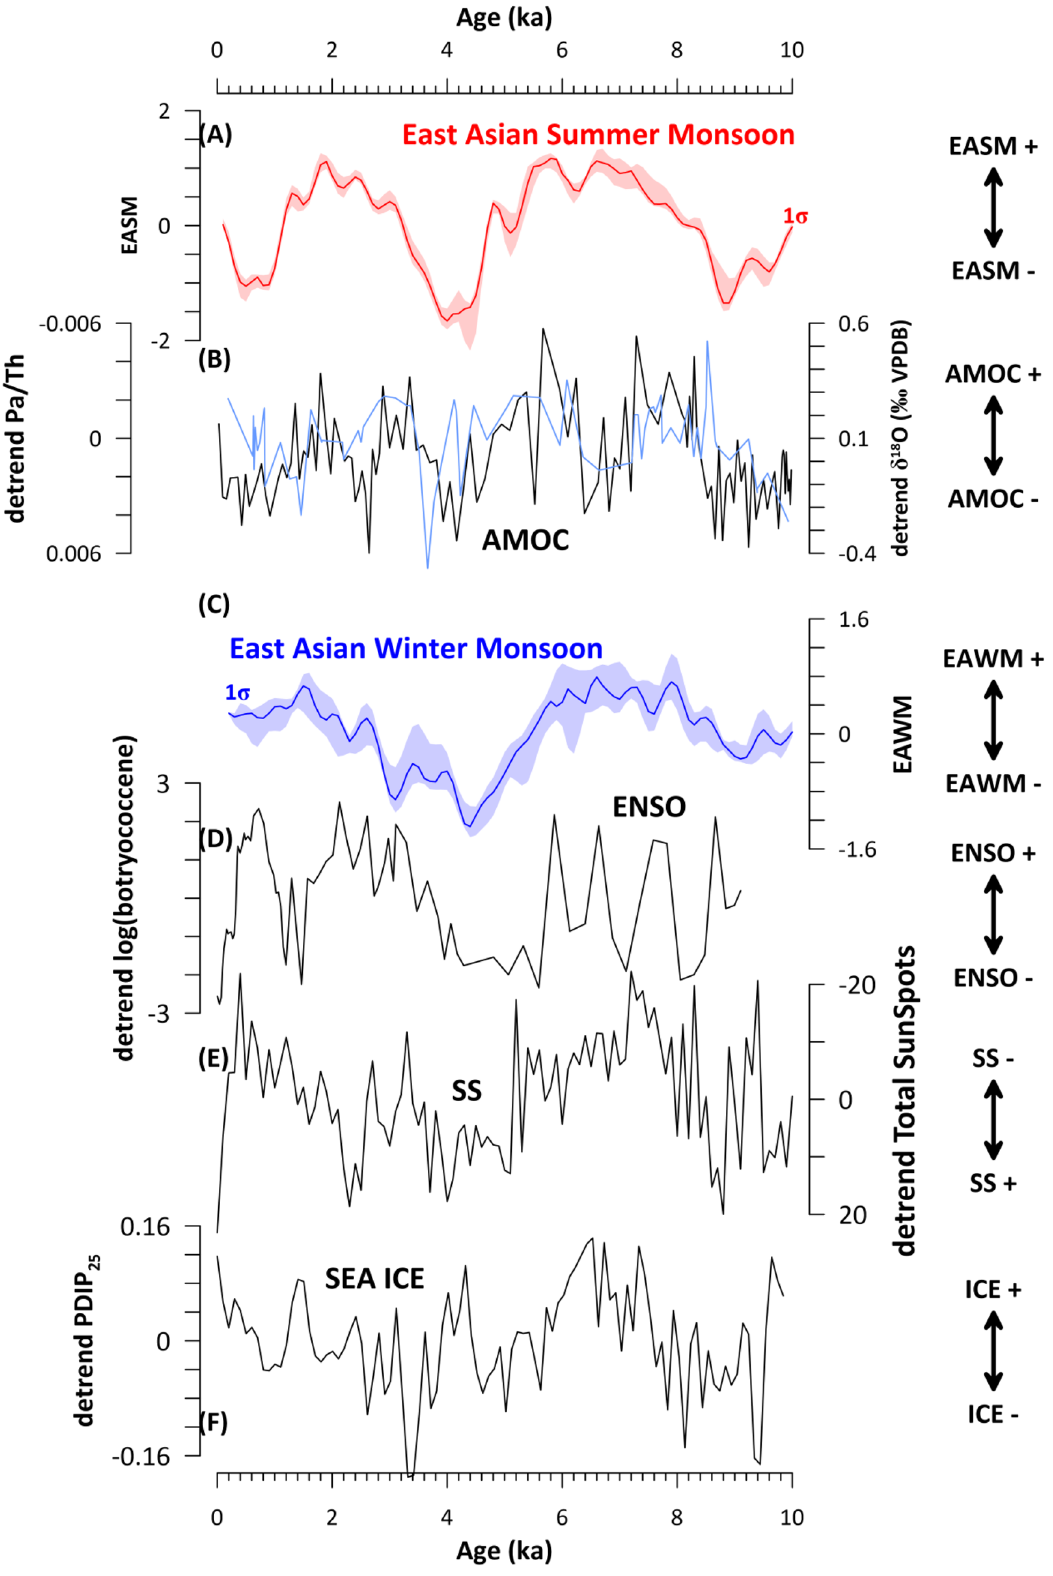
Figure 3. Comparison of East Asian summer (EASM) and winter (EAWM) monsoon stacks to their dominant driver. ( A ) East Asia summer monsoon (EASM) stack with 1 σ uncertainty (this study); ( B ) Proxies for Atlantic Meridional Overturning Circulation (AMOC) based on detrended Δδ 18 O w of Site RAPiD-12-1K 30 (black line) and detrended Pa/Th concentrations of Site ODP1063 29 (blue line); ( C ) East Asia winter monsoon (EAWM) stack with 1σ uncertainty (this study); ( D ) Proxy for El Niño-Southern Oscillation (ENSO) based on detrended log(botryococcene concentration in μg/g) derived from El Junco 31 ; ( E ) detrended Total Number of Sun Spots (SS) 32 ; ( F ) Proxy for Arctic sea ice coverage based on the concentrations of brassicasterol (PBIP 25 ) concentration derived from Site ARAB2B-1A 33